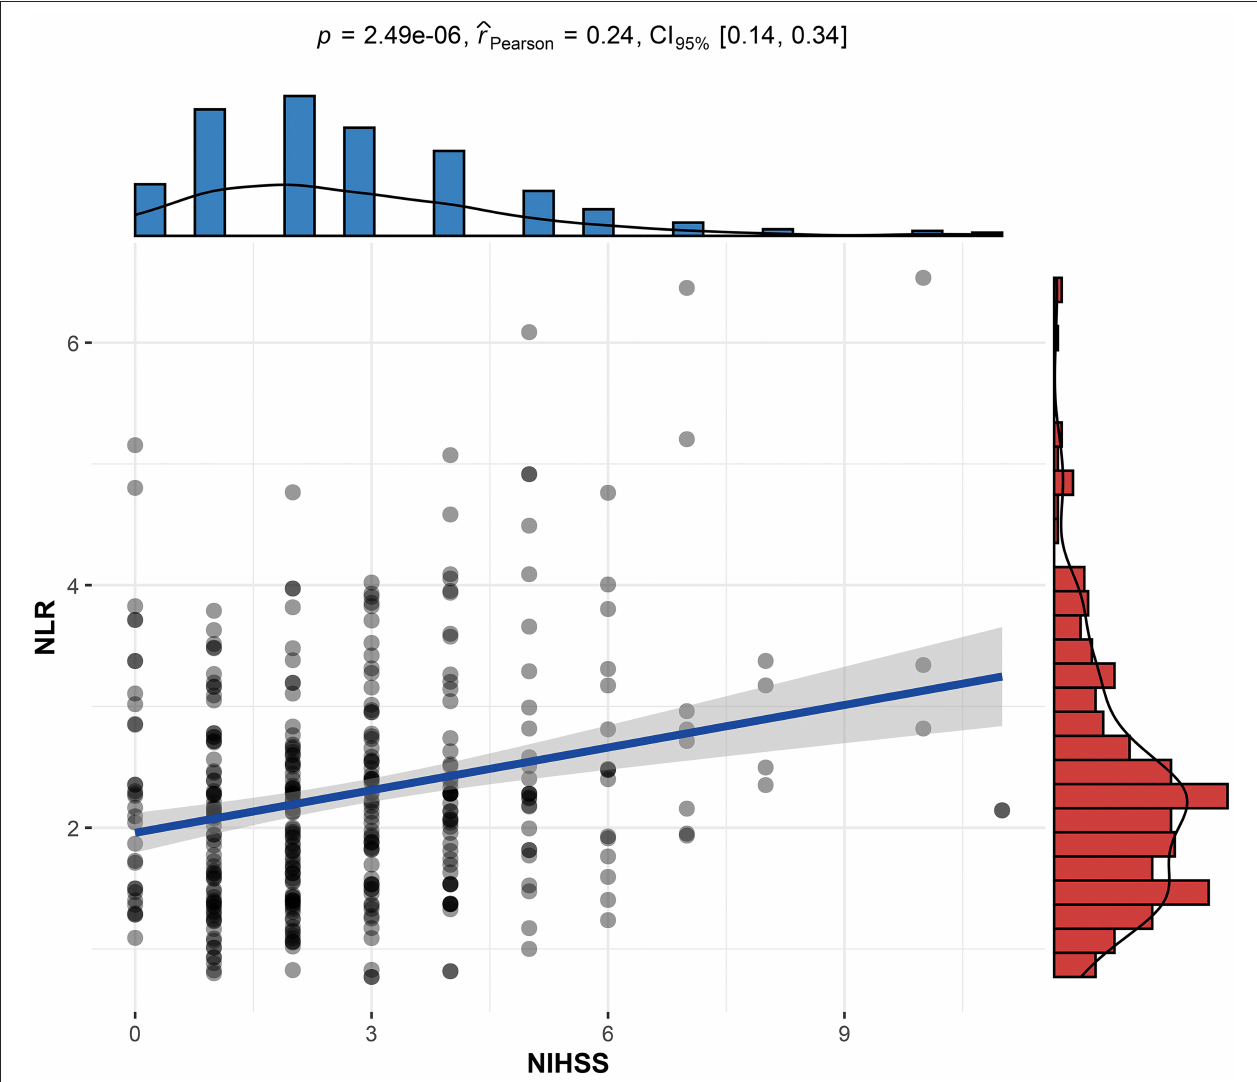
FIGURE 2 | Linear correlation between the stroke patient’s NLR and NIHSS score. NLR, neutrophil-to-lymphocyte ratio; NIHSS, National Institutes of Health Stroke Scale on admission; PSCI, poststroke cognitive impairment.